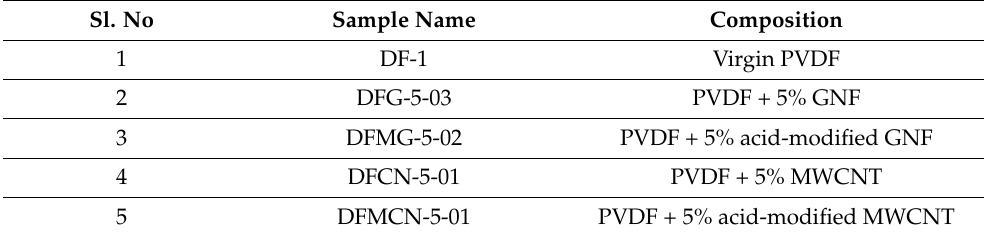
Table 1. Nomenclature of the prepared